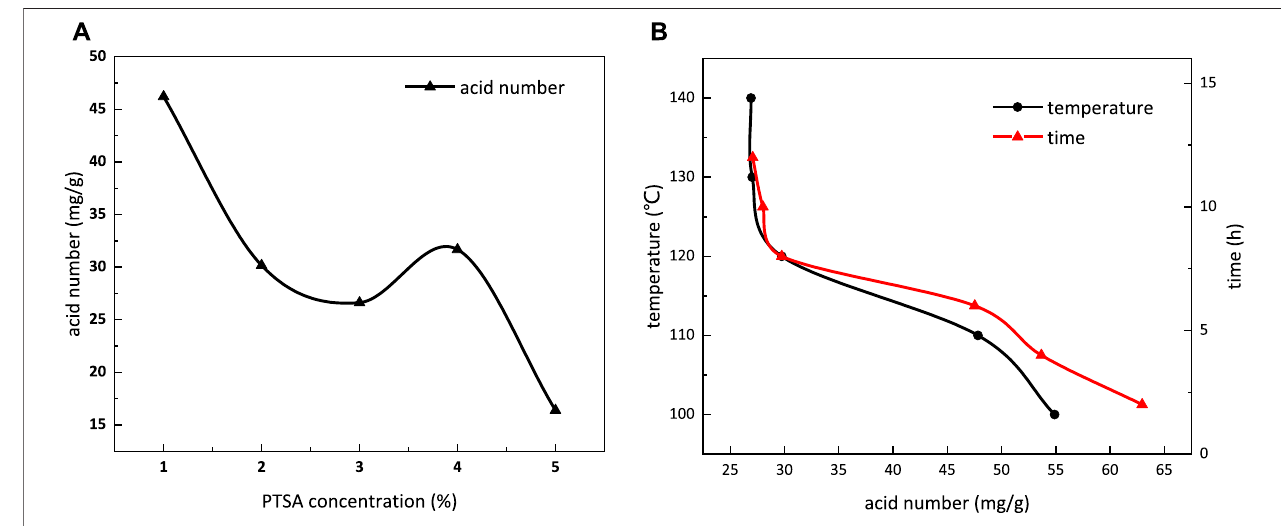
FIGURE 5 | In fl uence of PTSA concentration (A) and temperature and reaction time (B) on the acid number in the esteri fi cation reaction.